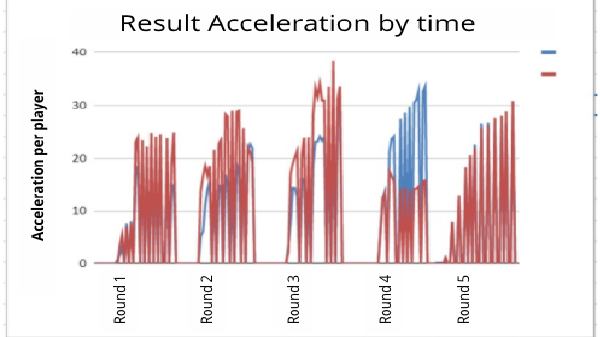
Figure 6. the average acceleration of the teams during the 5 interaction rounds at Carnaboi